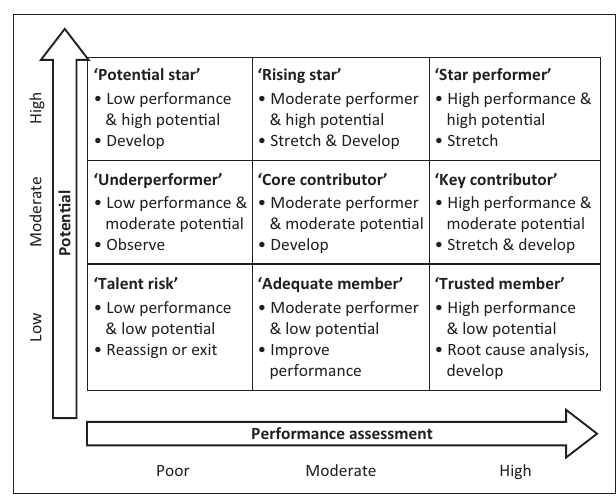
FIGURE 2: A version of the General Electric nine-box talent measurement